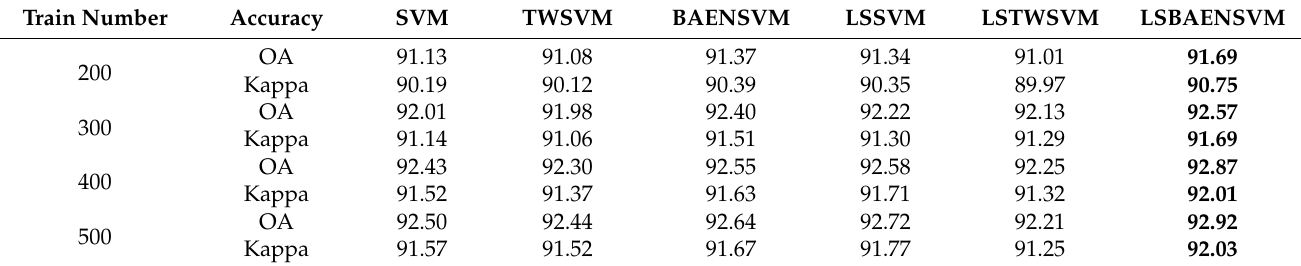
Table 8. Classification results of Salinas hyperspectral images.